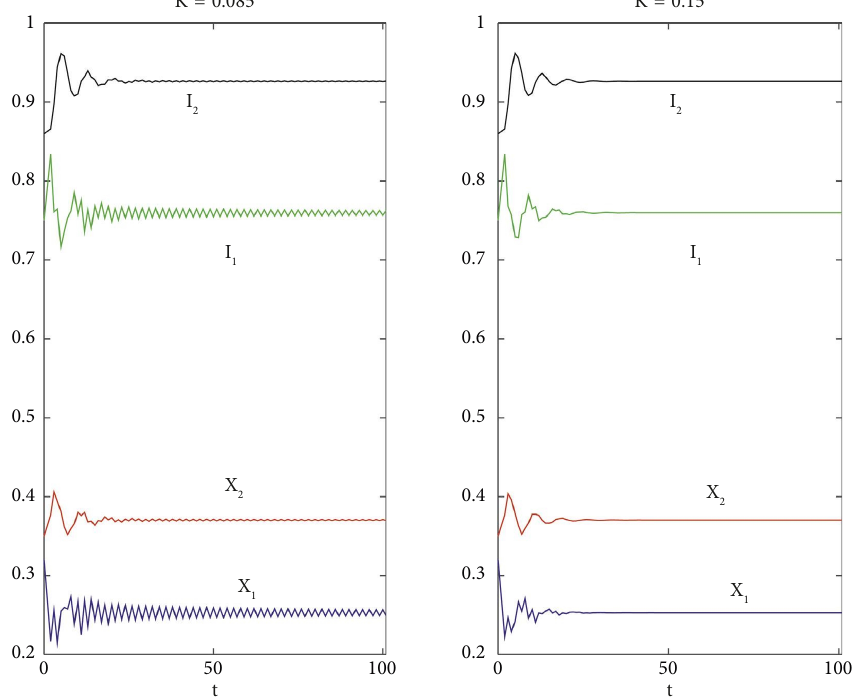
Figure 8: Evolution paths of discrete dynamical systems (21) under diferent gain